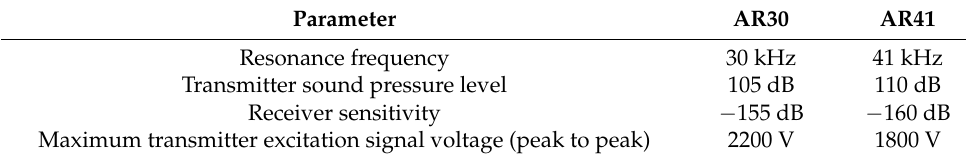
Table 1. Parameters of the selected ultrasonic transducers.